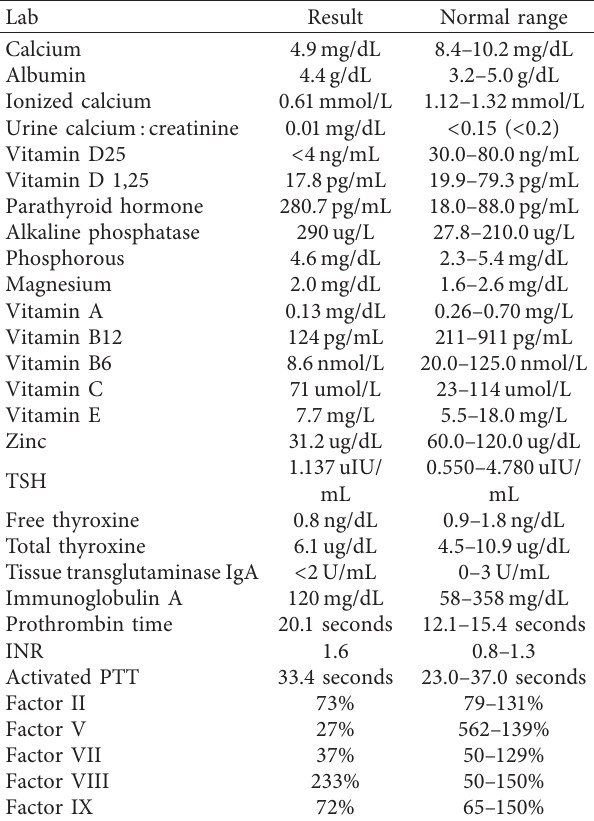
Table 1: Initial laboratory tests performed.